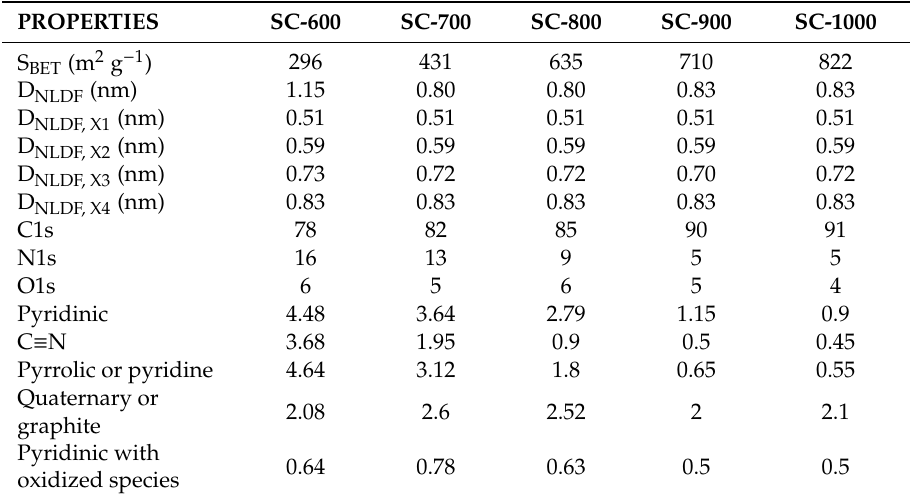
Table 2. Textural and chemical properties of PANMFs carbonized at 600, 700, 800, 900, and 1000 ◦ C. S BET —BET area; D NLDFT —preferential pore diameter calculated by the NLDFT model; in the case of CO 2 adsorption, four pore sizes were observed (X1, X2, X3, and X4). XPS general for carbon, nitrogen, and oxygen. High-resolution XPS spectra in the